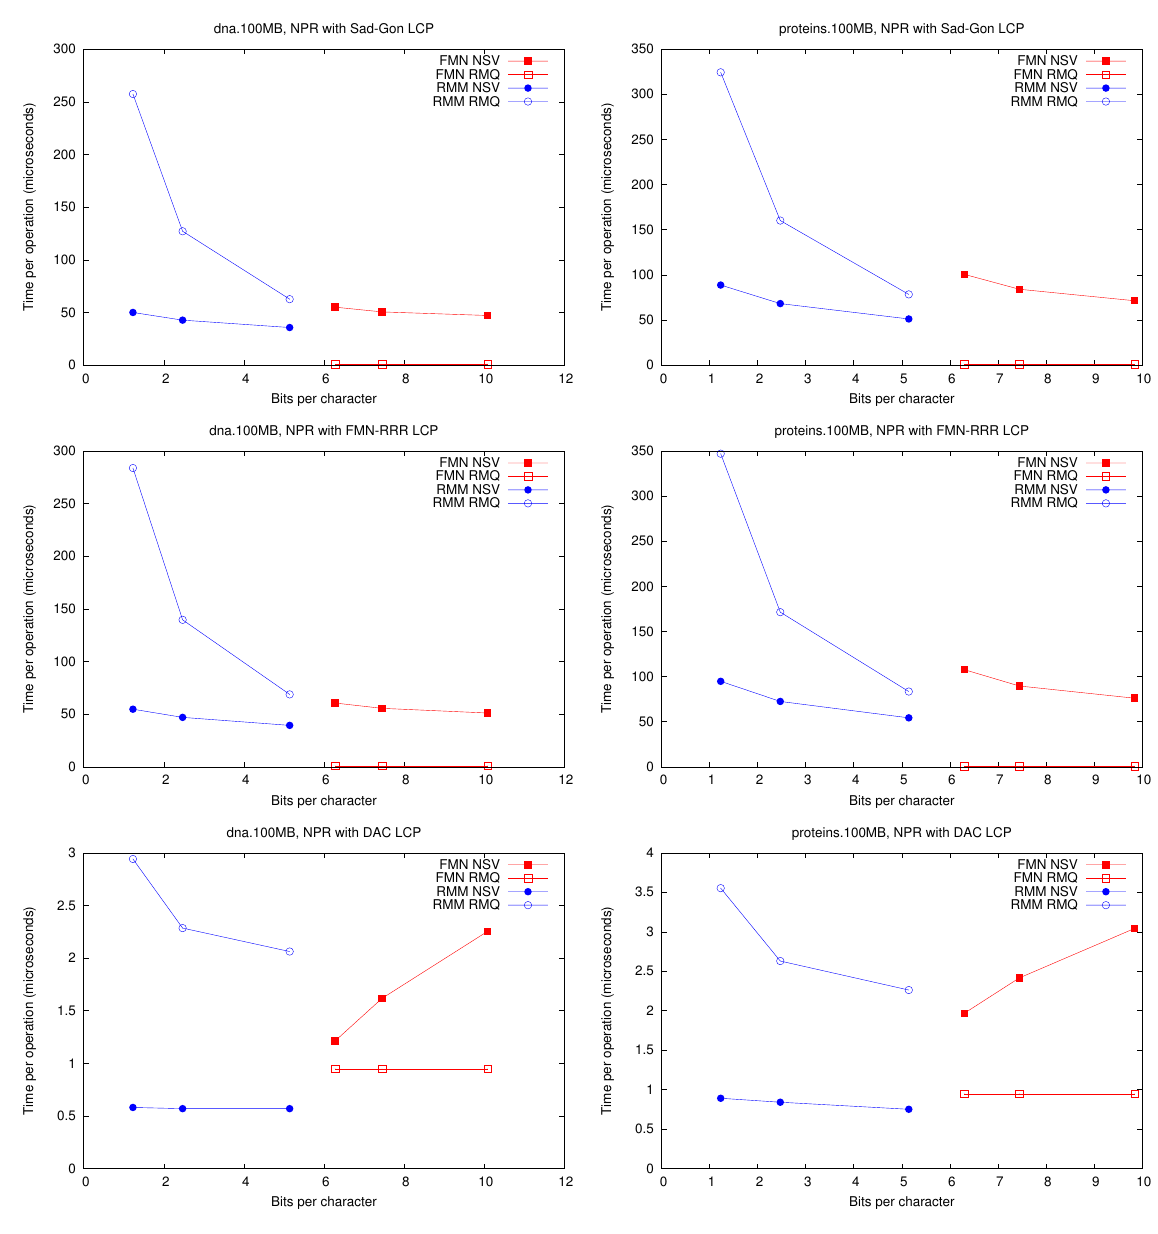
Figure 3. Space/Time for the operations NSV and RMQ . Times for PSV are identical to those for NSV